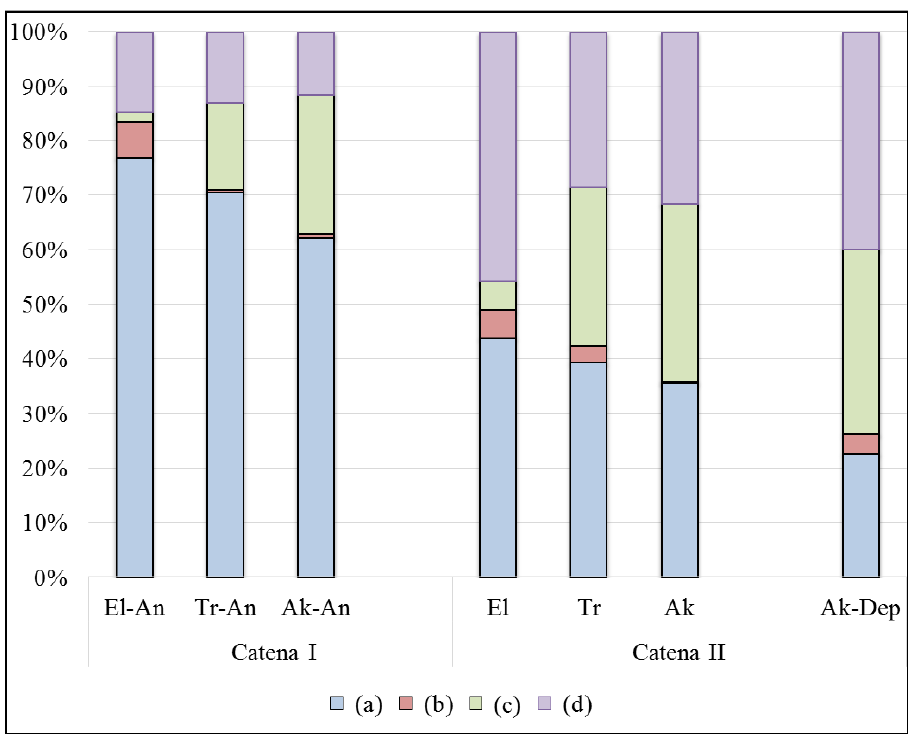
Figure 3. The stock of live (above-ground) phytomass by agrobotanical groups of plants (a, cereal grasses; b, legumes; c, sedges; d, forb grasses). grasses; b, legumes; c, sedges; d, forb